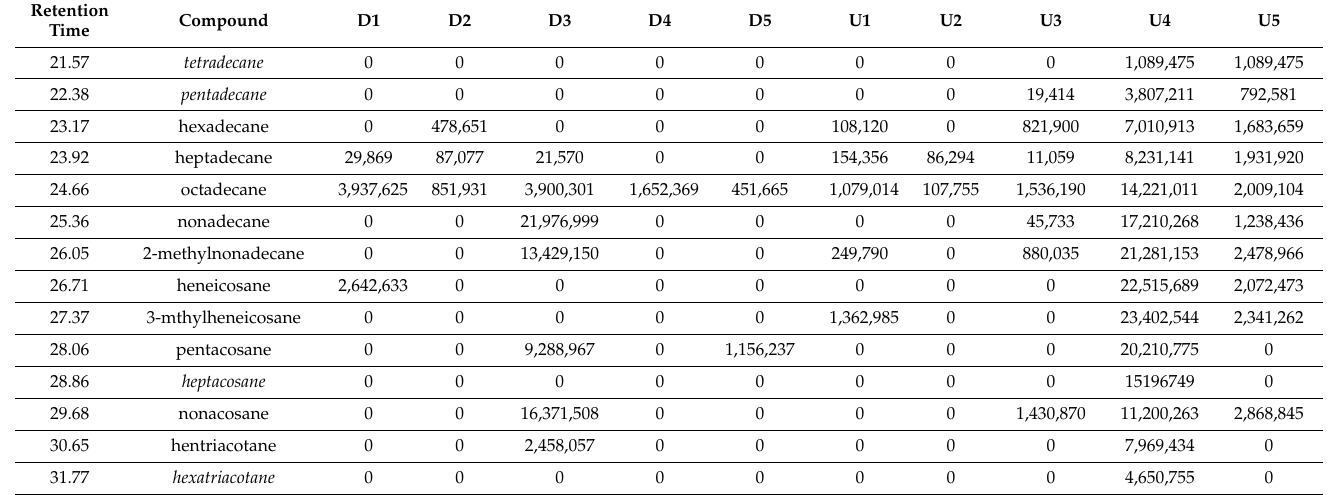
Table 8. Table summarising the compounds, retention time of the compounds and abundance per site. The compounds in italics showed a very restricted distribution.